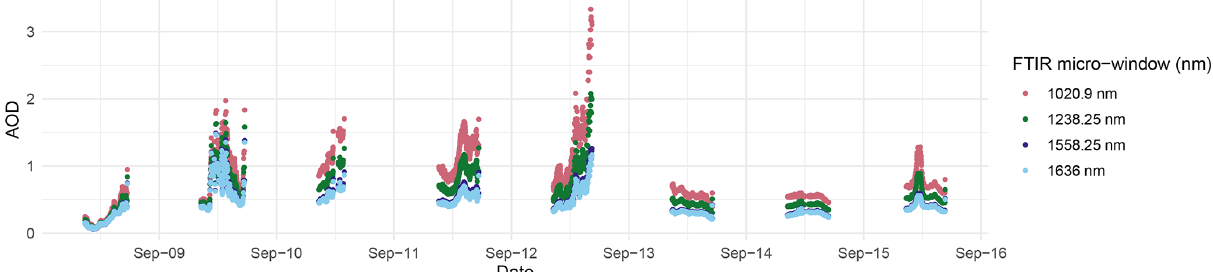
Figure B2. Time series of AOD for the four micro-windows from 8 to 15 September